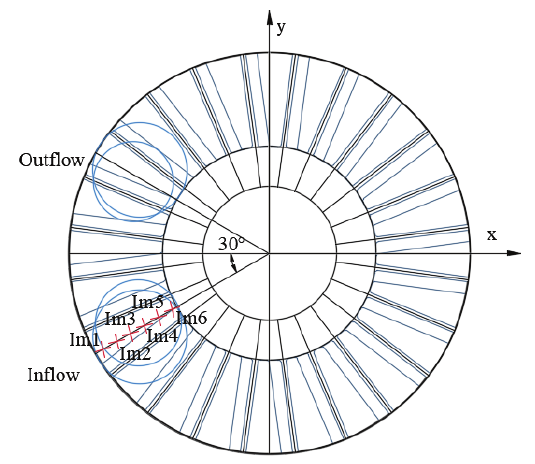
Figure 7. Monitoring points.